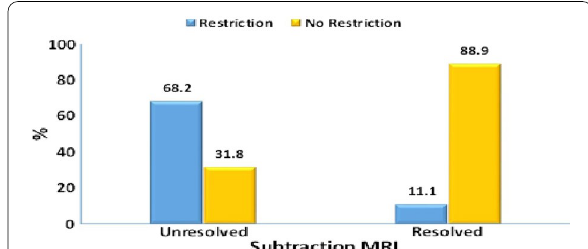
Fig. 4 A chart assessing the diffusion pattern of all lesions residual and resolved in relation to the added subtraction dynamic MRI technique as a gold standard